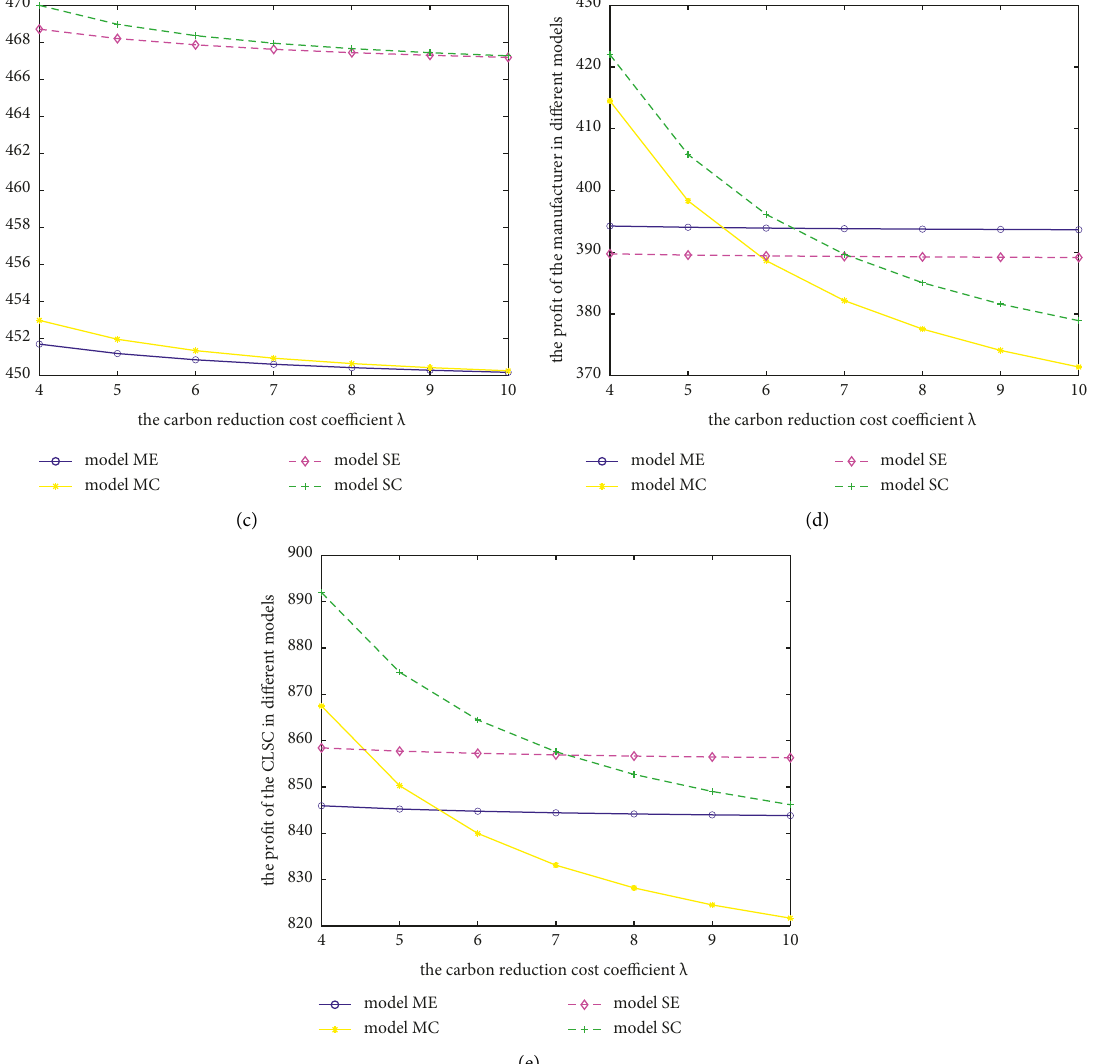
Figure 4: The carbon reduction cost coefficient λ . (a) The capacity investment of manufacturing in different models. (b) The carbon reduction level in different models. (c) The profit of the supplier in different models. (d) The profit of the manufacturer in different models. (e) The profit of the CLSC in different